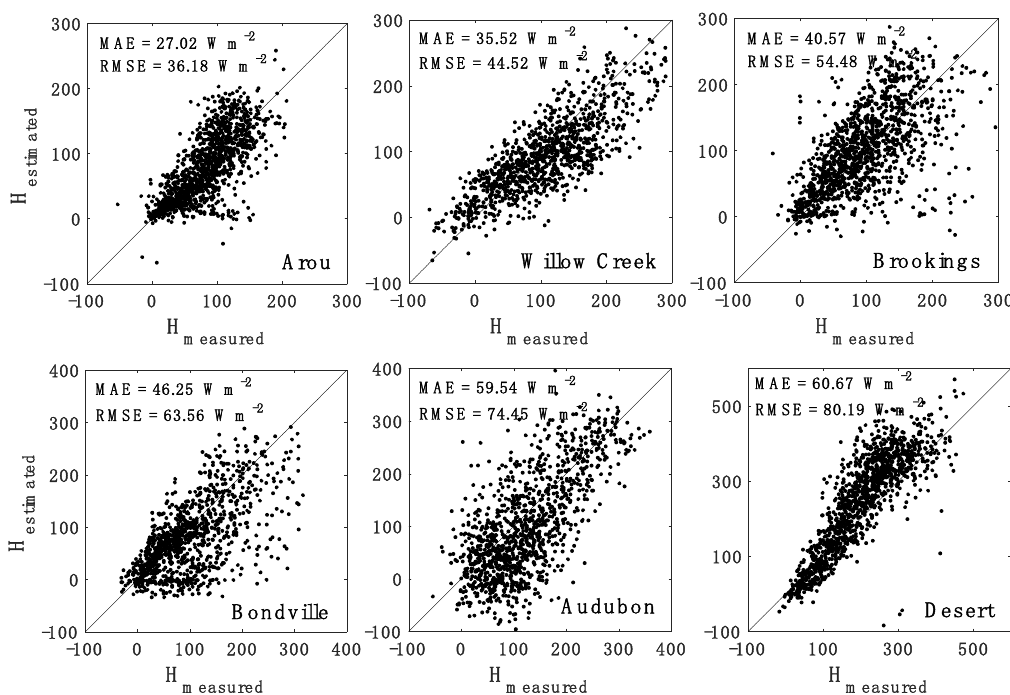
Figure 5. Scatterplot of half-hourly sensible heat flux ( H ) estimates versus observations at the six investigated sites.